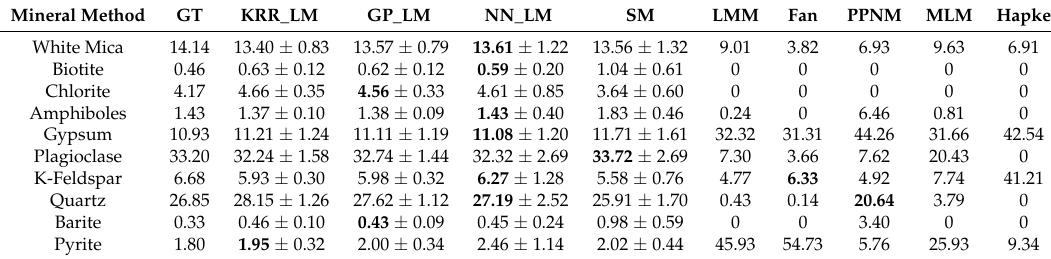
Table 5. The mean estimated fractional abundances of 186 test pixels (in %) of the drill core dataset using the supervised methods (100 runs) along with the estimated fractional abundances using the unsupervised methods. The best performances are denoted in